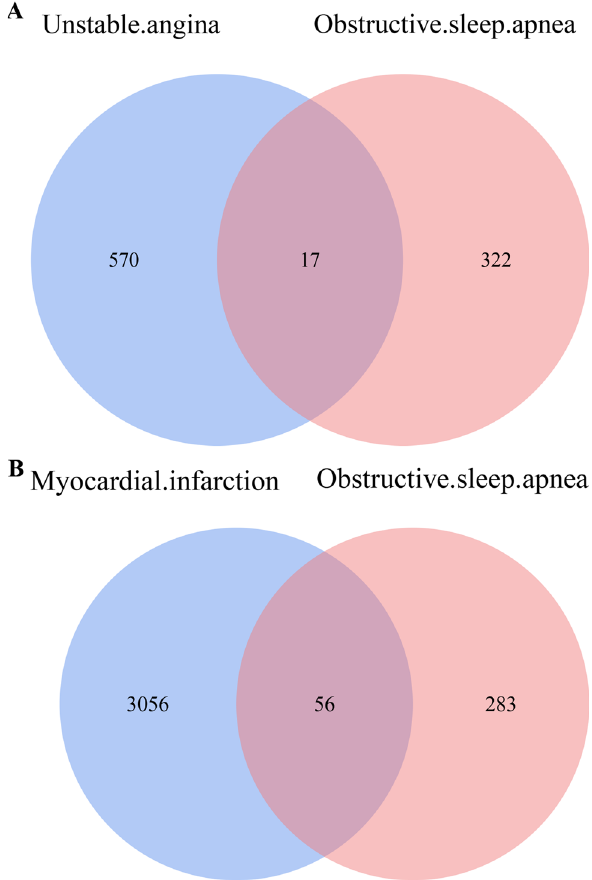
Figure 2. Venn diagram of DEGs from microarray data and genes list from text mining. ( A) Intersection of genes between DEGs generated from GSE60993 and obstructive sleep apnea gene list from text mining. ( B) Intersection of genes between DEGs generated from GSE24519 and obstructive sleep apnea gene list from text mining. DEGs, differentially expressed